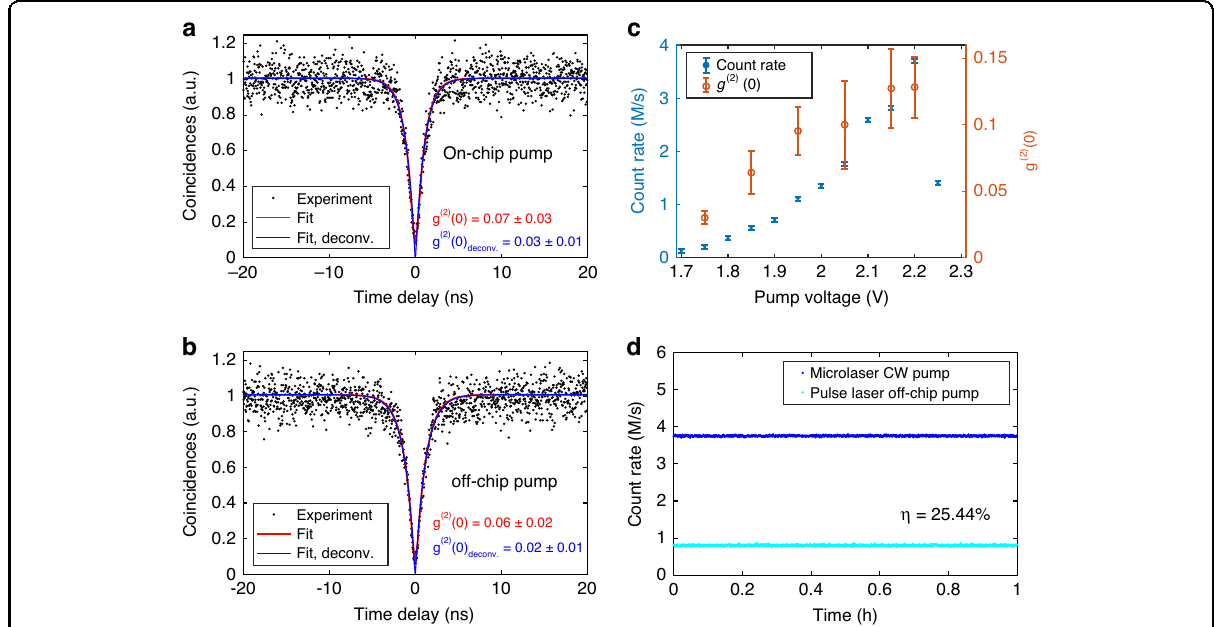
Fig. 5 Source brightness and single-photon purity. a , b Second-order correlation as a function of time delay for the QD pumped by the on-chip microlaser and an external CW laser diode. Black dots mark experimental data. The red and blue curves are the fi ts with and without deconvolutions of the detector response, respectively. c Photon count rate (blue circles) and g (2) (0) (brown circles) as a function of the bias voltage applied to the micropillar laser. d Saturation count rates from X1 pumped by the micropillar laser (dark blue) operating in a CW mode and a fs pulsed laser (bright